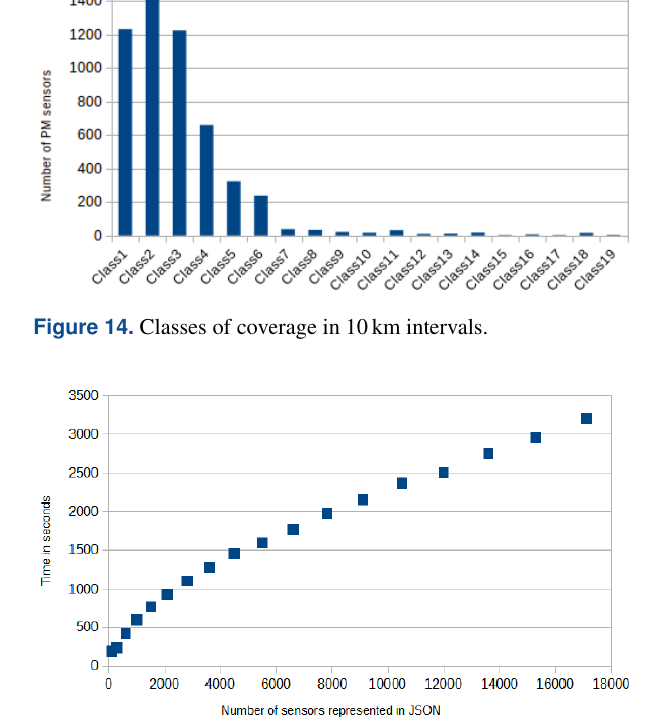
Figure 15. Time needed to create the RDF graph depending on the number of